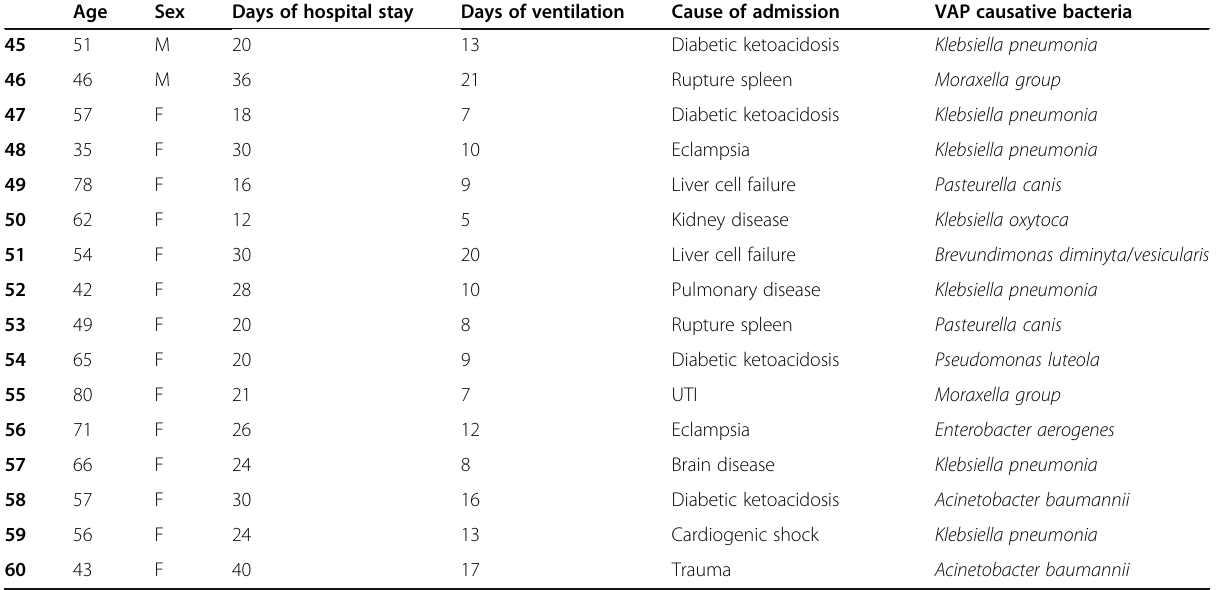
Table 1 Demographic data of VAP patients admitted to ICU of BSU Hospital (Continued)